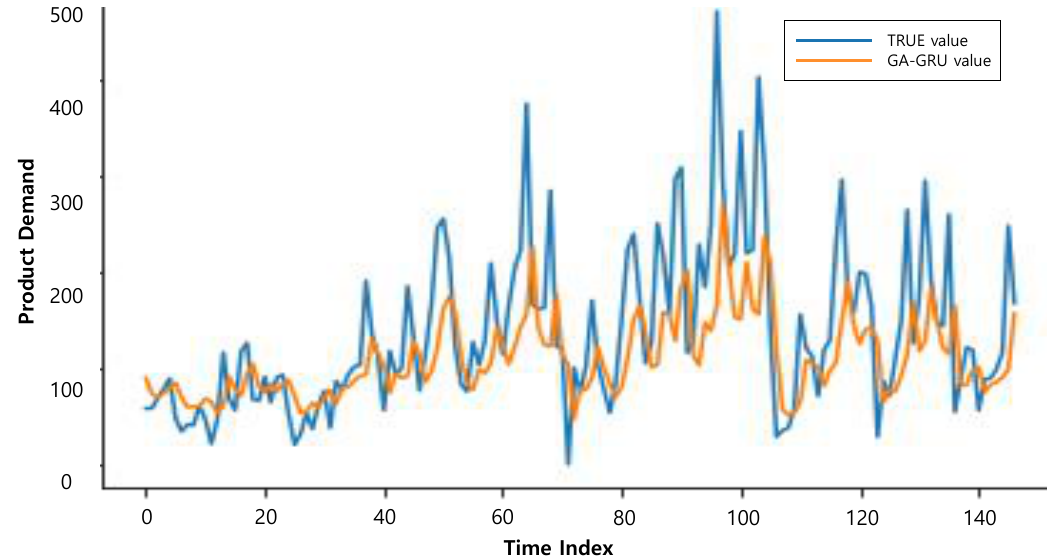
Figure 4. The graph of the forecasted demand generated by GA-GRU and real demand.